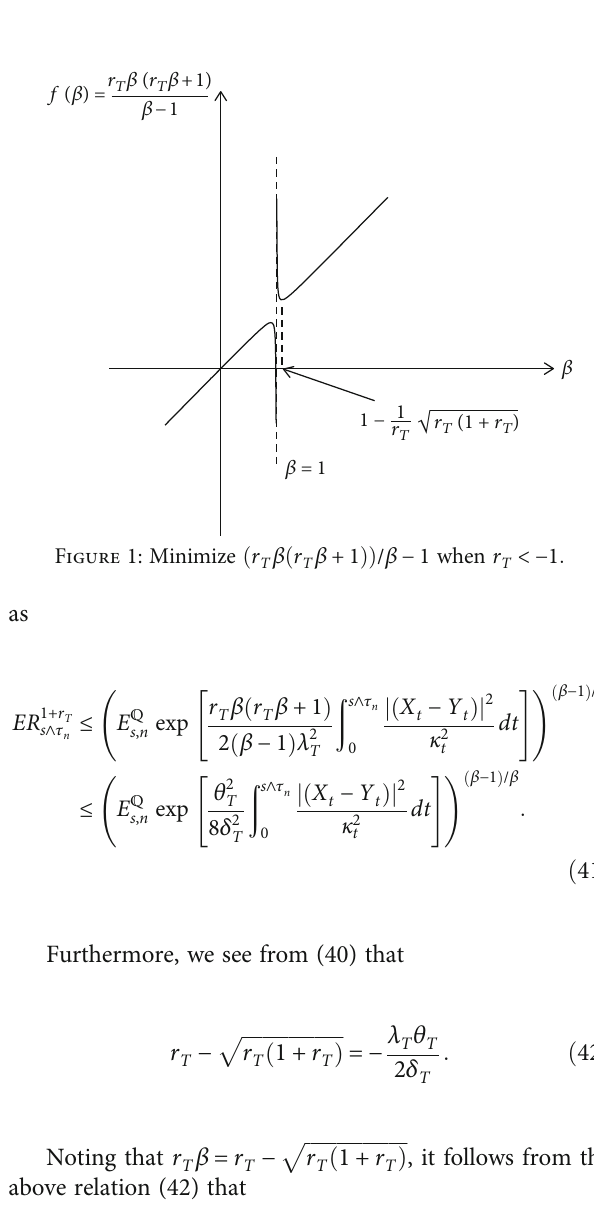
ffiffiffiffiffiffiffiffiffiffiffiffiffiffiffiffiffiffiffiffi r 1 + r T